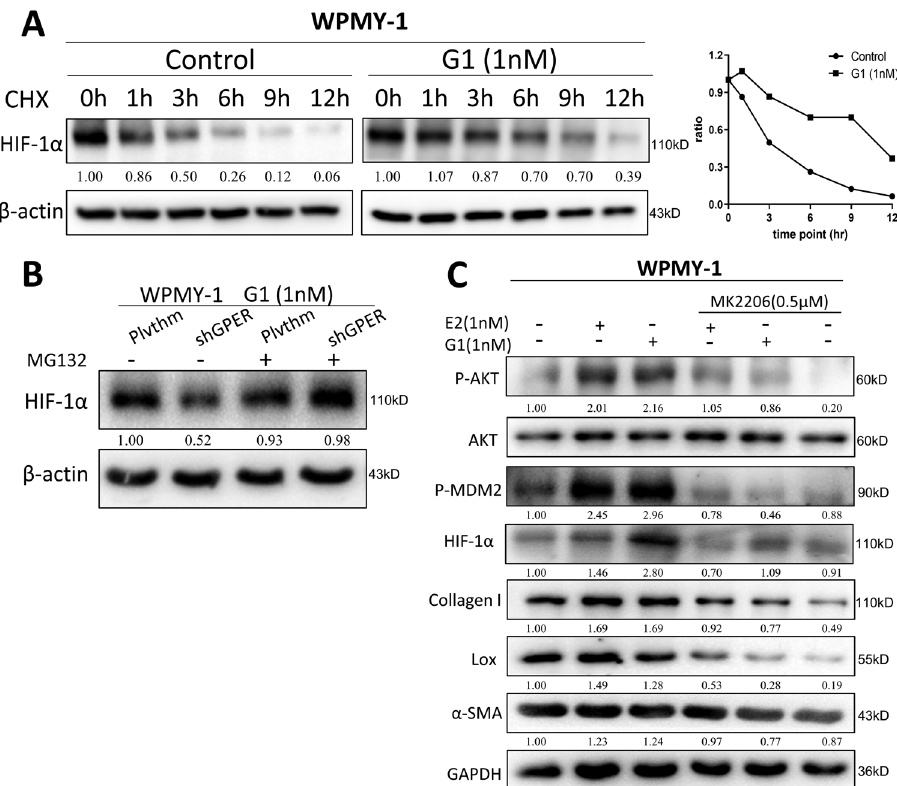
Fig. 5 Estrogen/GPER/G α i signaling increases HIF-1 α expression by altering protein stability of HIF-1 α . A WPMY-1 were pretreated with 10 mg/ml cycloheximide (CHX) and then treated with vehicle control or 1 nM G1 for 0 – 12 h. HIF-1 α protein levels were analyzed by western blot. The right graph is the quanti fi ed HIF-1 α degradation curve. B Plvthm/shGPER-WPMY-1 were treated with or without MG132 (5 mM) for 3 h in the presence of 1 nM G1, and then HIF-1 α protein levels were analyzed by western blot. C WPMY-1 were treated with 1 nM E2 or 1 nM G1 with or without 0.5 µM MK2206 for 72 h, and the expression of the indicated genes was detected by western blot. GAPDH or β -actin was used as the loading control.